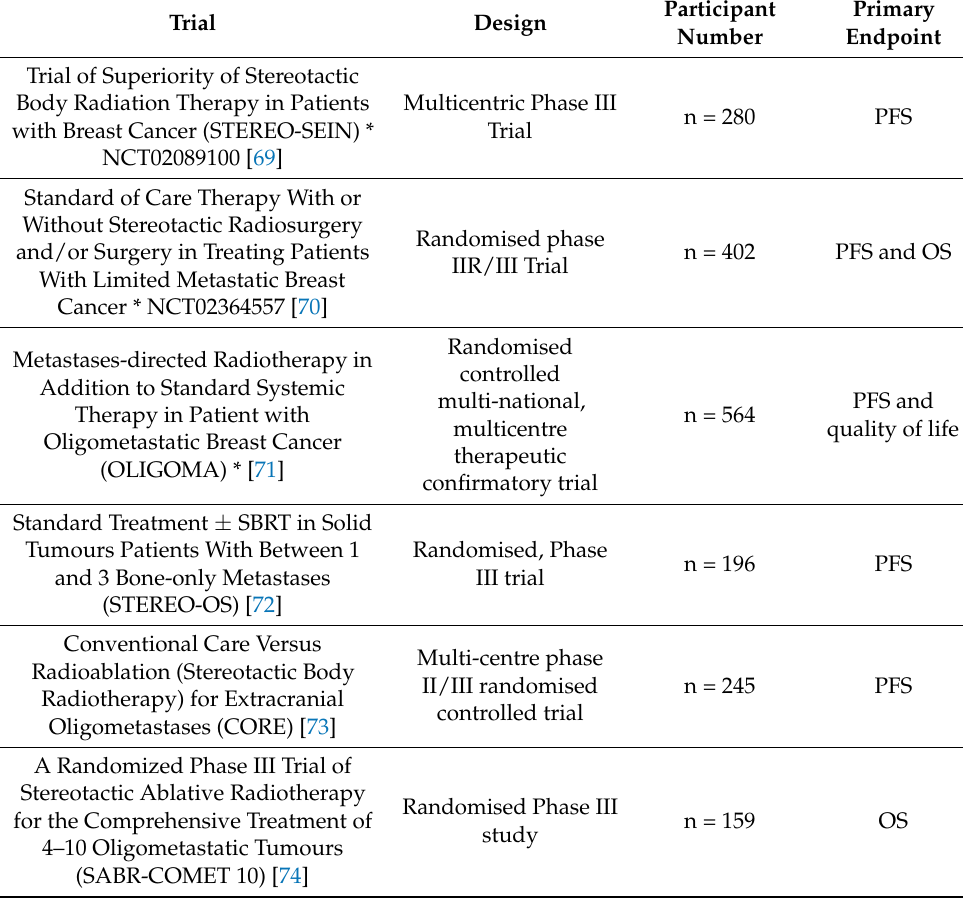
Table 1. Ongoing randomised trials investigating SABR in oligometastatic breast